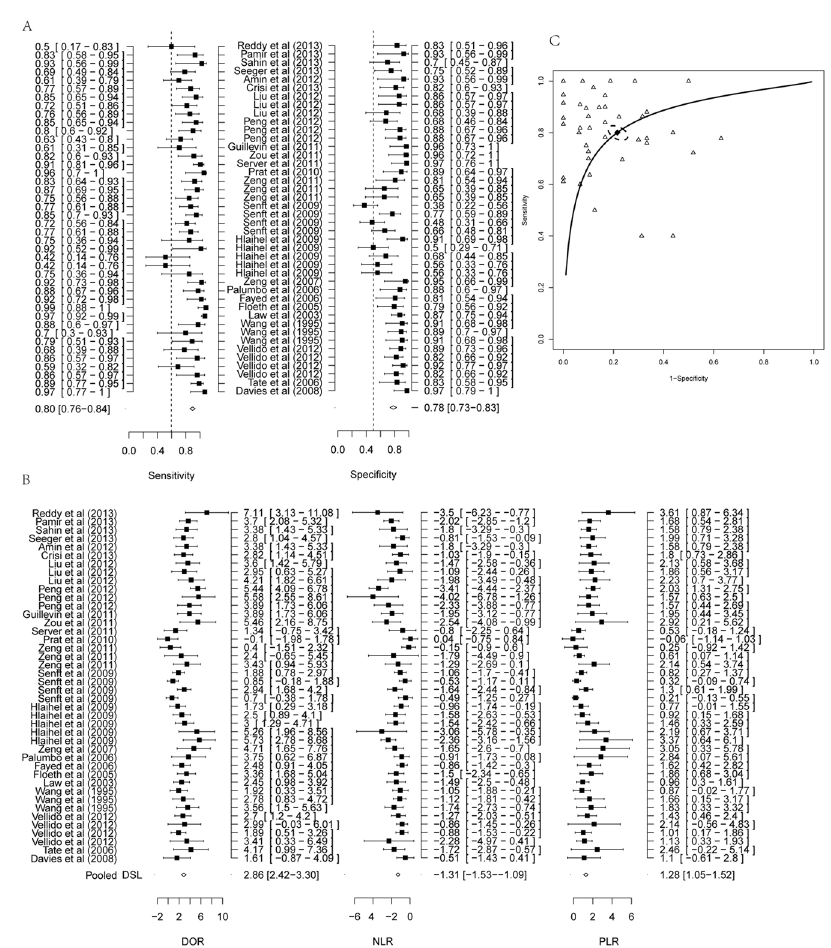
Figure 3. Forest plot of estimate of diagnostic accuracy of MRS. (A) Forest plot of estimate of sensitivity and specificity of MRS. (B) Forest plot estimateofPLR, NLR andDORof MRS. (C) SROC curve ofdiagnostic performance of MRS from all studies. Solidline representsthe ROCcurve, and dottedline represented 95% confidence ellipse. Hollow triangle represented observed data from each study and solid rhombus represented the summary estimate.